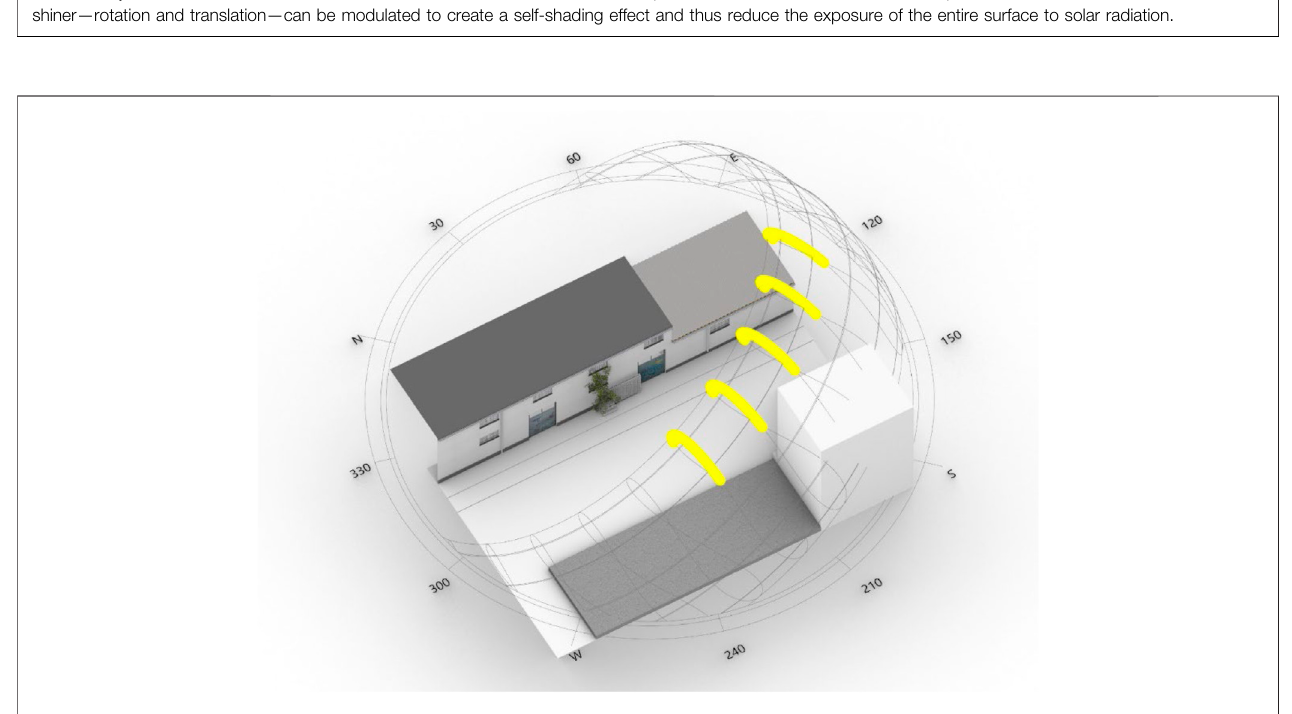
FIGURE 5 | Accumulated sun path simulation in Ladybug for the south-west oriented façade between fi rst of June and 31st of August within the time-period of 11.00 a.m. to 4.00 p.m.